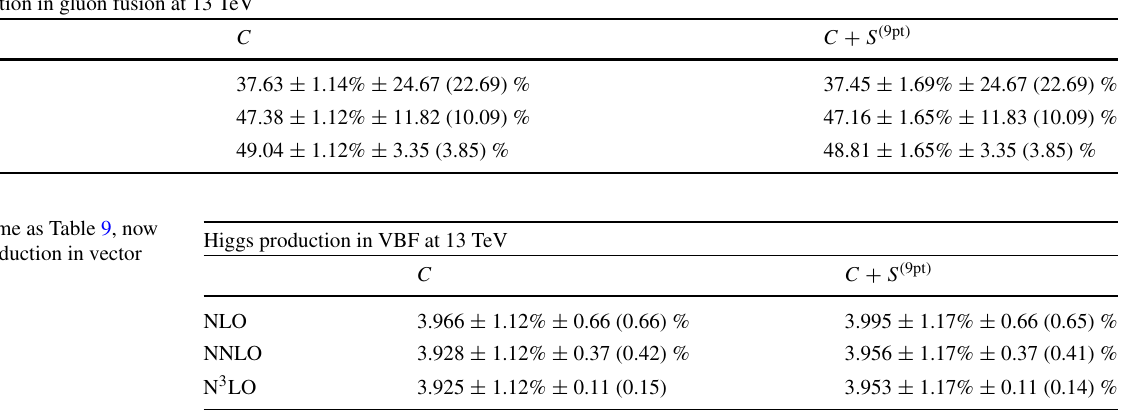
evaluatedbothusingthetheorycovariancematrix(9-pointprescription) or, in parenthesis, a (symmetrized) envelope of the 7-point scale vari- ations (see Sect. 8.1), obtained by taking the maximum value between the lower and upper uncertainties